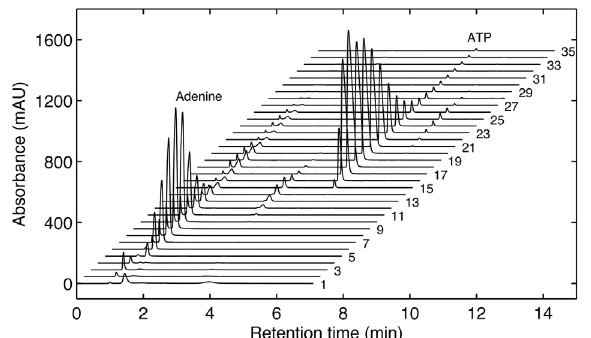
Figure 12. HPLC analysis of fractions collected from DEAE ion- exchange chromatographic puri fi cation of [4 ′ - 2 H]ATP. Chromato- grams are shifted by a fi xed percentage in time and absorbance for visual clarity. Fraction numbers are labeled at the beginning of of the fi